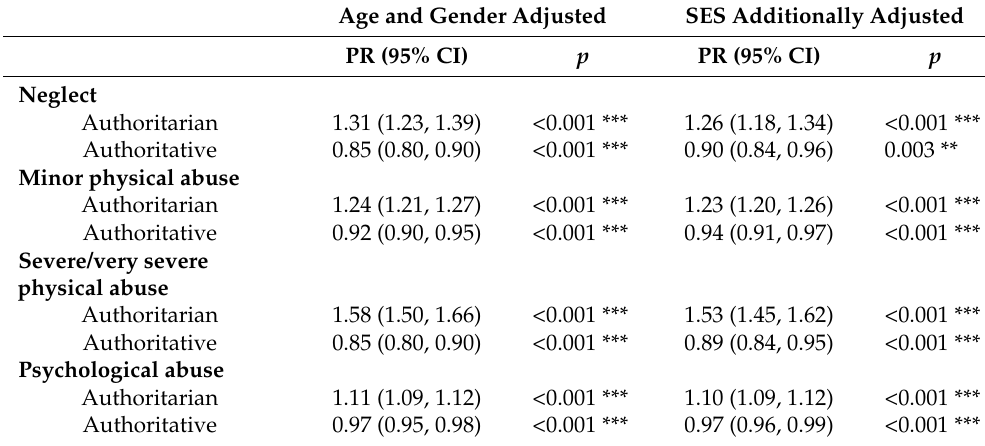
Table 3. Association between parenting style and child maltreatment.